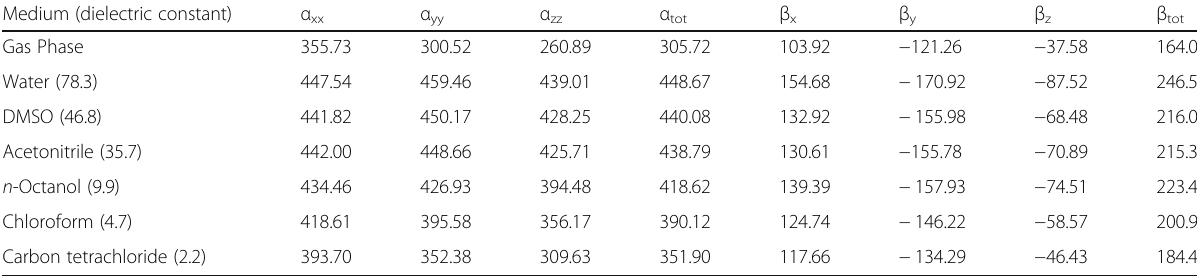
Table 4 Effect of solvent polarity on polarizability (a.u.) and first order hyperpolarizability (a,u) Medium (dielectric